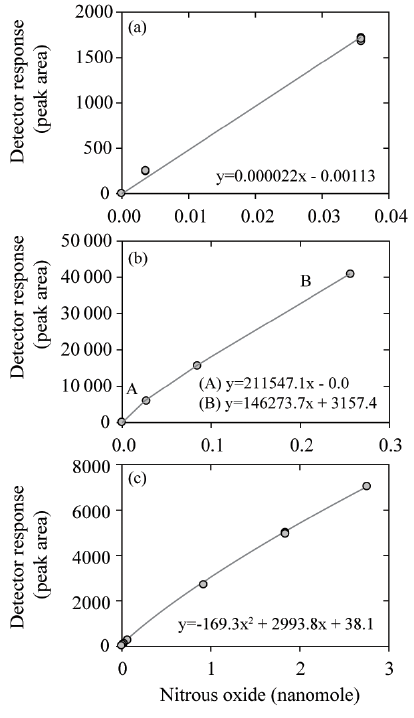
Figure 6. Three calibration curves for nitrous oxide measurements using an ECD including linear (a) , multilinear (b) , and quadratic (c)